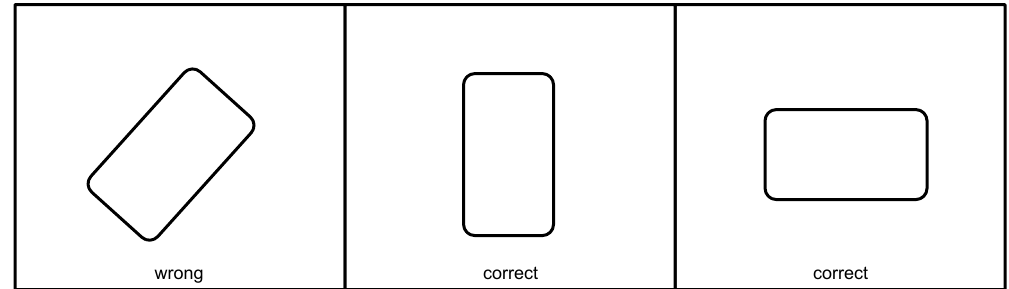
Figure 4.5: The node orientation must be horizontally or